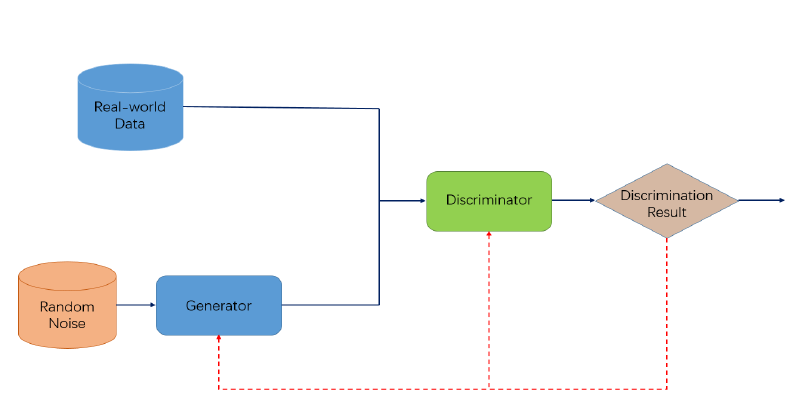
Figure 2. The general semantics flow chart of generative adversarial network